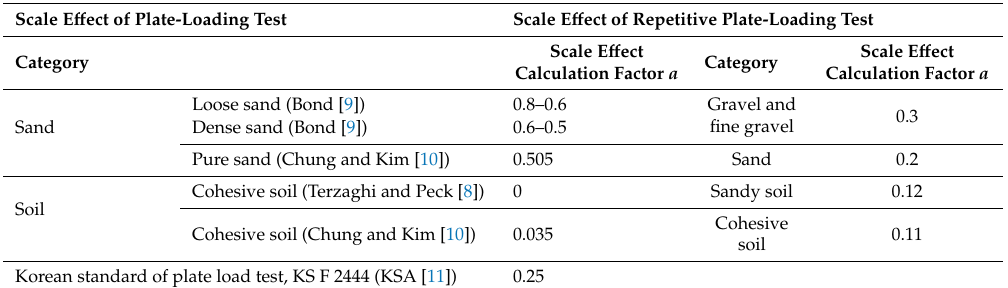
Table 7. Scale-e ff ect comparison between the plate loading and repetitive plate-loading